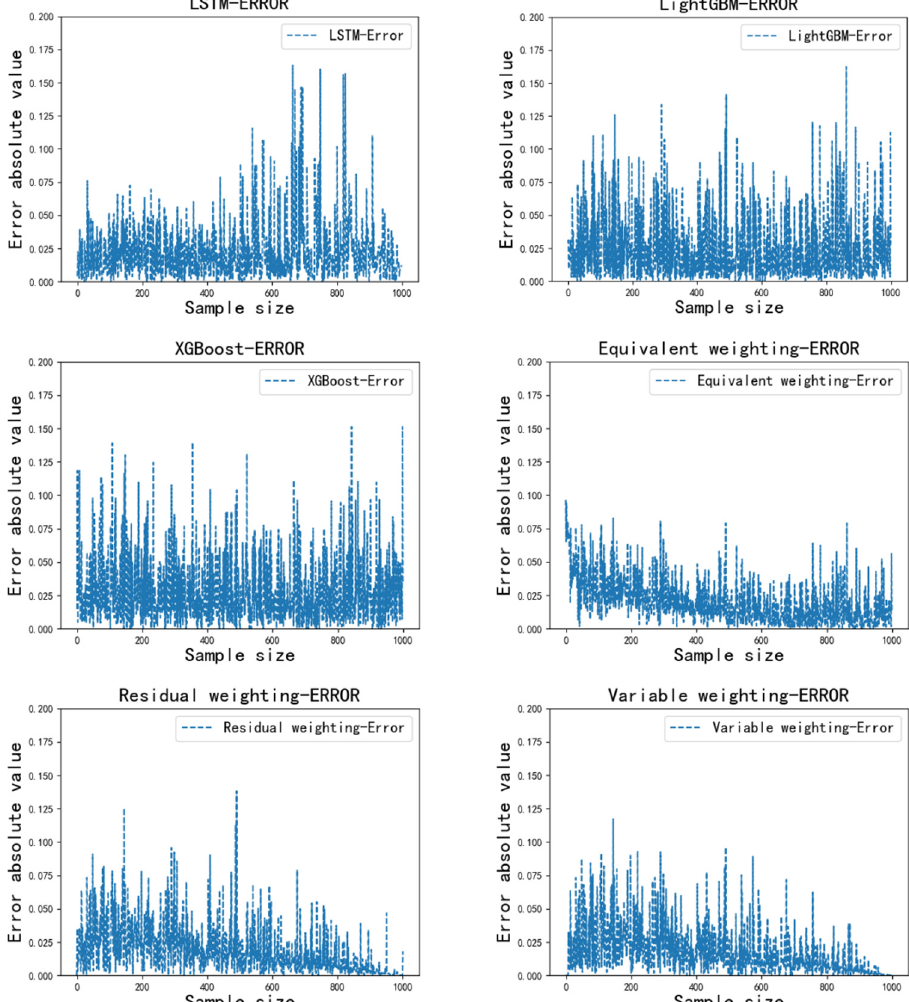
Figure 6. Prediction result and real results of each model.